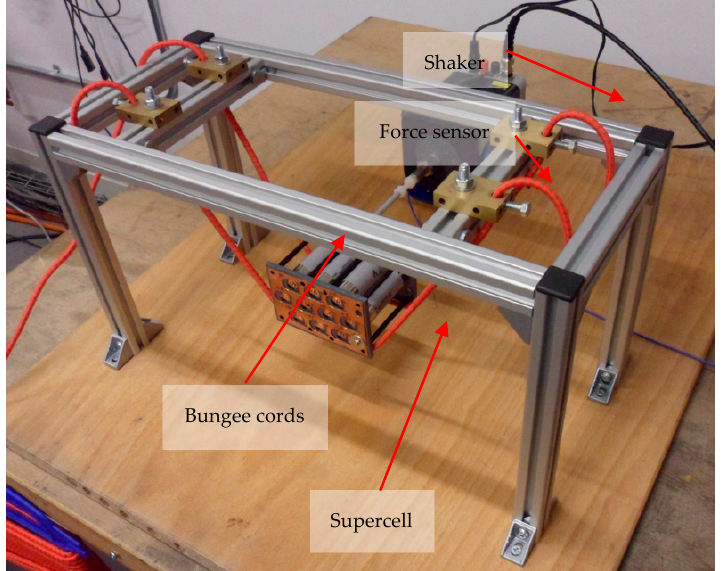
Figure 9. EMA of supercells in a free–free condition.